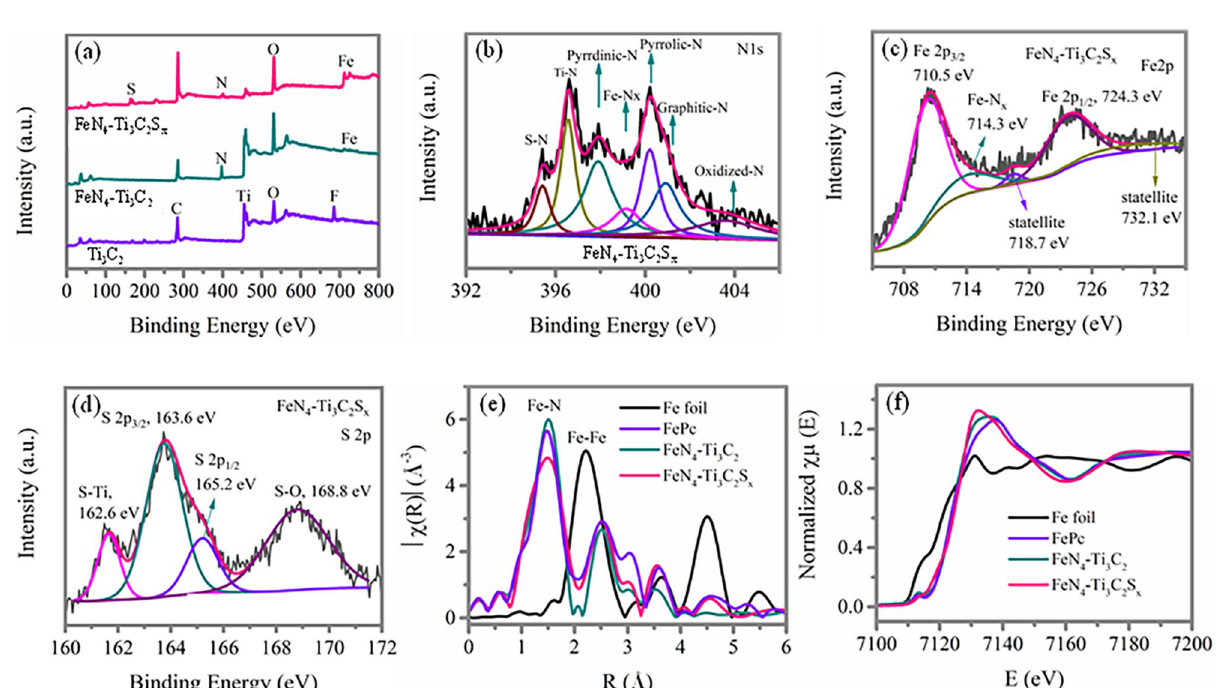
Fig. 2 a XPS survey spectra of pristine Ti 3 C 2 , FeN 4 –Ti 3 C 2 , and FeN 4 –Ti 3 C 2 S x . High-resolution XPS spectra of b N 1 s , c Fe 2 p , and d S 2 p for sample